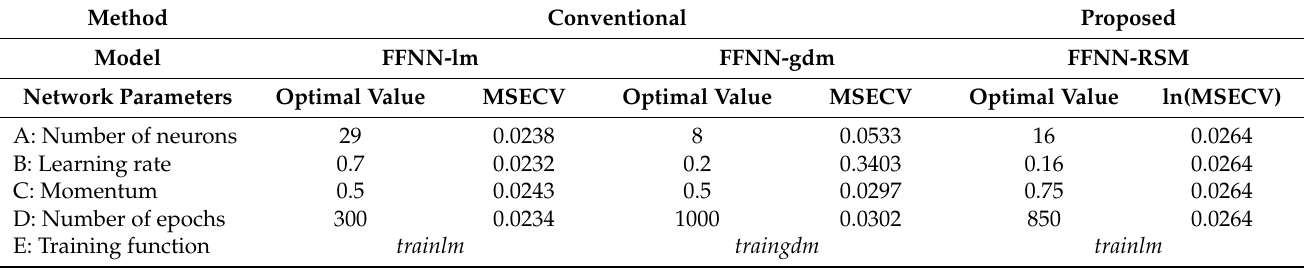
Table 6. The best network parameters for the FFNN-lm, FFNN-gdm, and FFNN-RSM models.